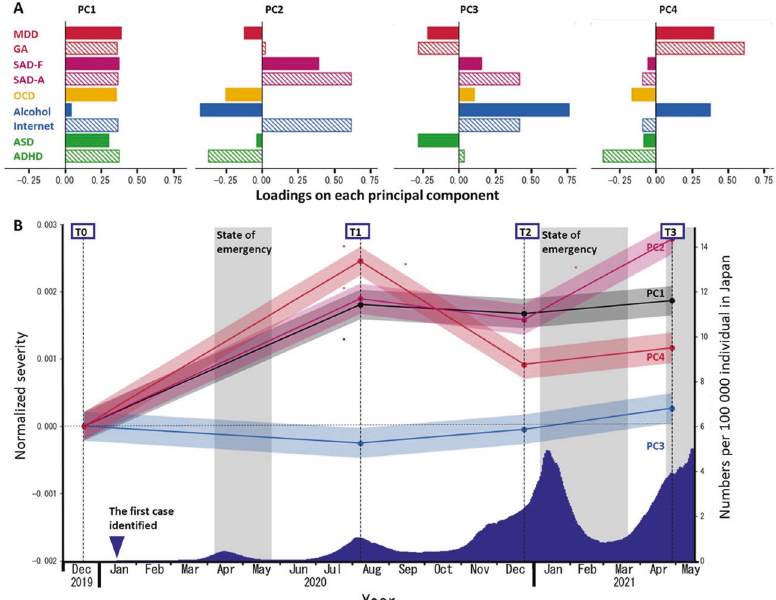
Fig. 3 Trajectories of PC scores obtained from multidimensional psychiatric scores in the study population ( N = 2274). A Loadings of psychiatric disorder scores for each principal component. B Trajectories of the average of each PC are shown. The blue area under the curve represents a 15-day moving average of daily new COVID-19 cases per 100,000 Japanese residents. Signs of PCs were arranged so that each maximum loading assumed a positive value. Asterisks indicate signi fi cant changes in PC score from the previous time point ( p < 0.05, Bonferroni-corrected). All PC scores during the pandemic (T1, T2, and T3) except those of PC3 are signi fi cantly higher than the scores pre- pandemic (T0). MDD major depressive disorder as measured using the CES-D, GA general anxiety as measured with the STAI-Y state,